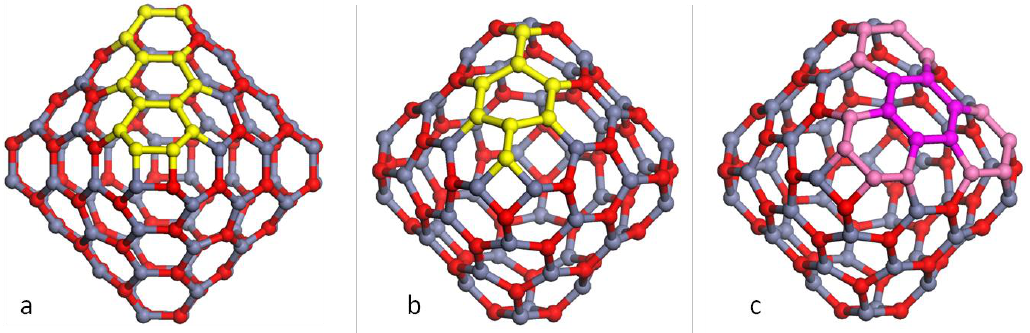
Figure 2. Models of high symmetry (MX) the ladder of hexagonal rings, highlighted in yellow, that corresponds to one of the twelve edges of an octahedron; ( b ) n = 48, symmetry T to one of twelve edges highlighted in yellow; ( c ) n = 48, symmetry T twelve patchworks that correspond to the octahedron side highlighted in